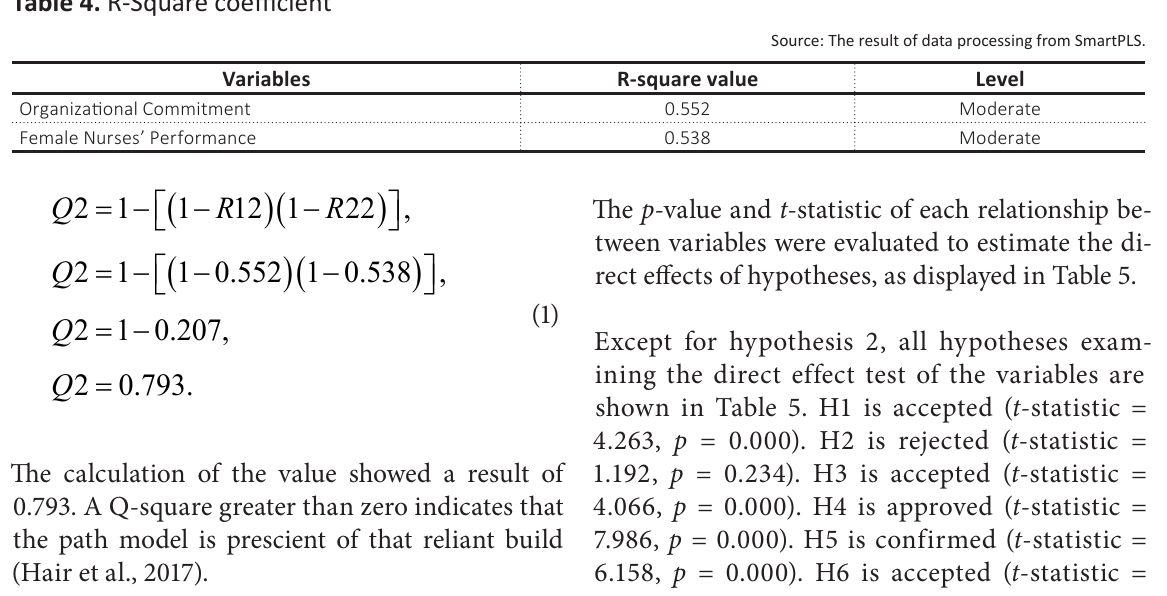
Table 2. Convergent validity and composite reliability test